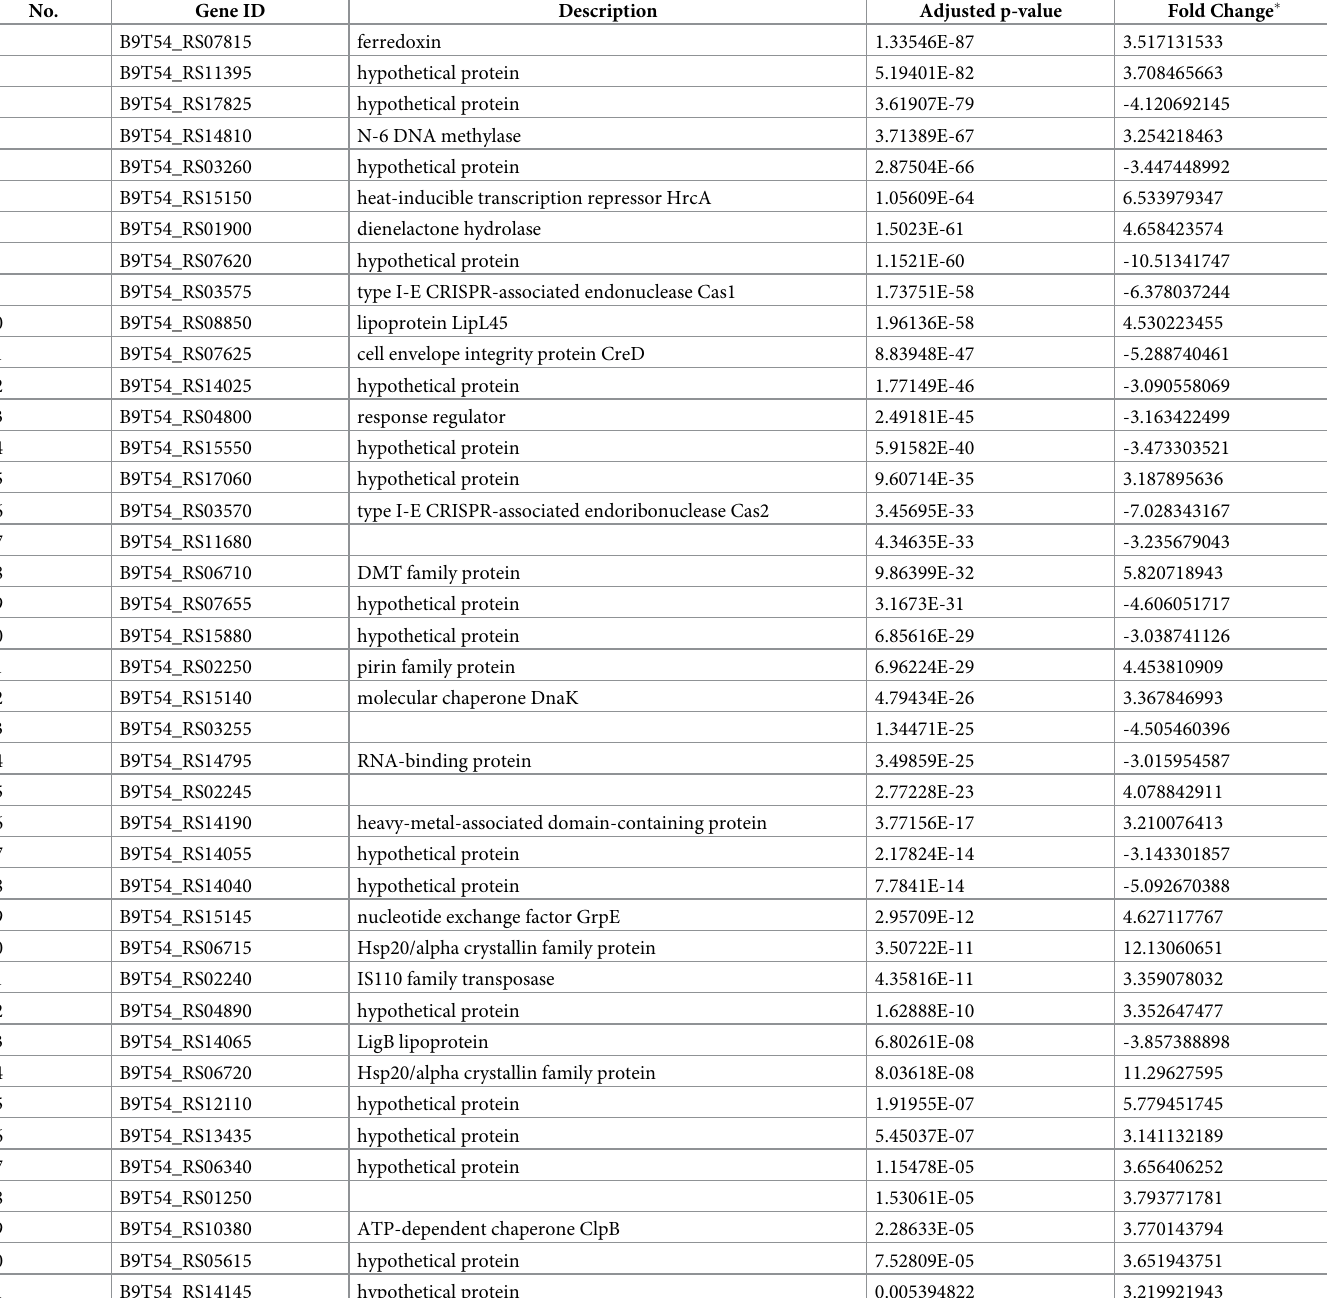
Table 5. The forty-one significantly differentially expressed genes between HB203 grown at 29˚C and 37˚C. All genes are relative to the HB203 reference genome and annotated by the HB203 gene ID. � Positive and negative fold change values indicate higher expression at 37 and 29˚C, respectively.